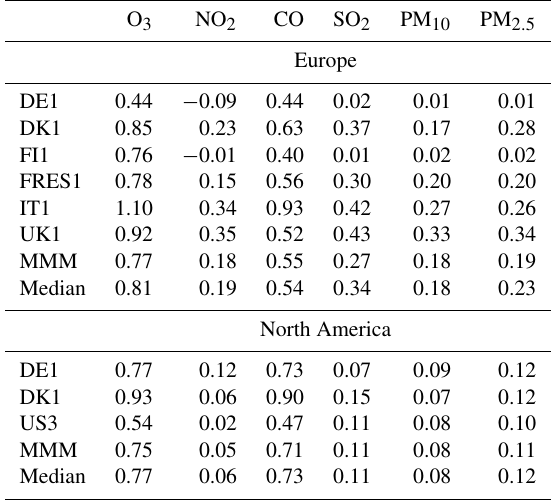
Table 6. Annual mean RERER values calculated for the multi- model mean (MMM) ensembles over Europe and North